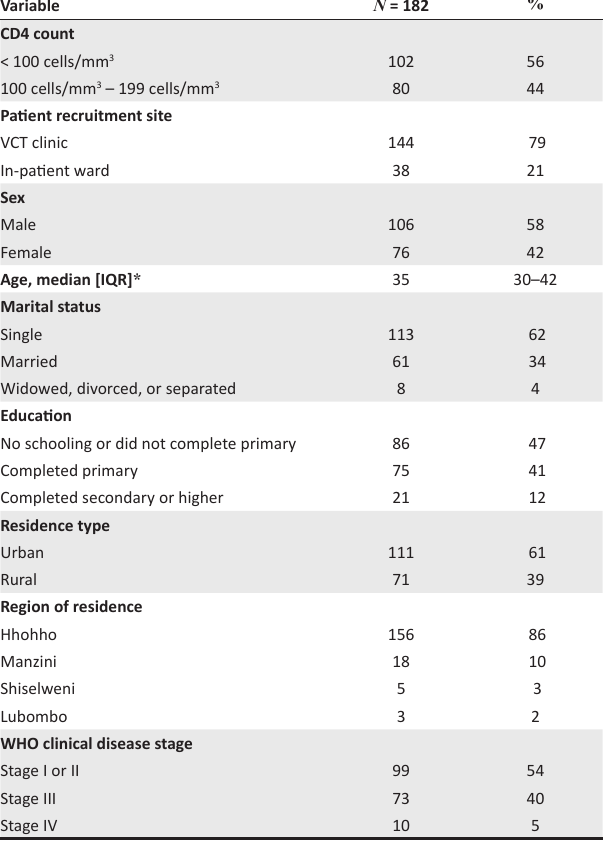
TABLE 1: Characteristics of patients enrolled in the CrAg screening study of patients with a CD4 count < 200 cells/mm 3 , Eswatini, August 2014 to March 2015.